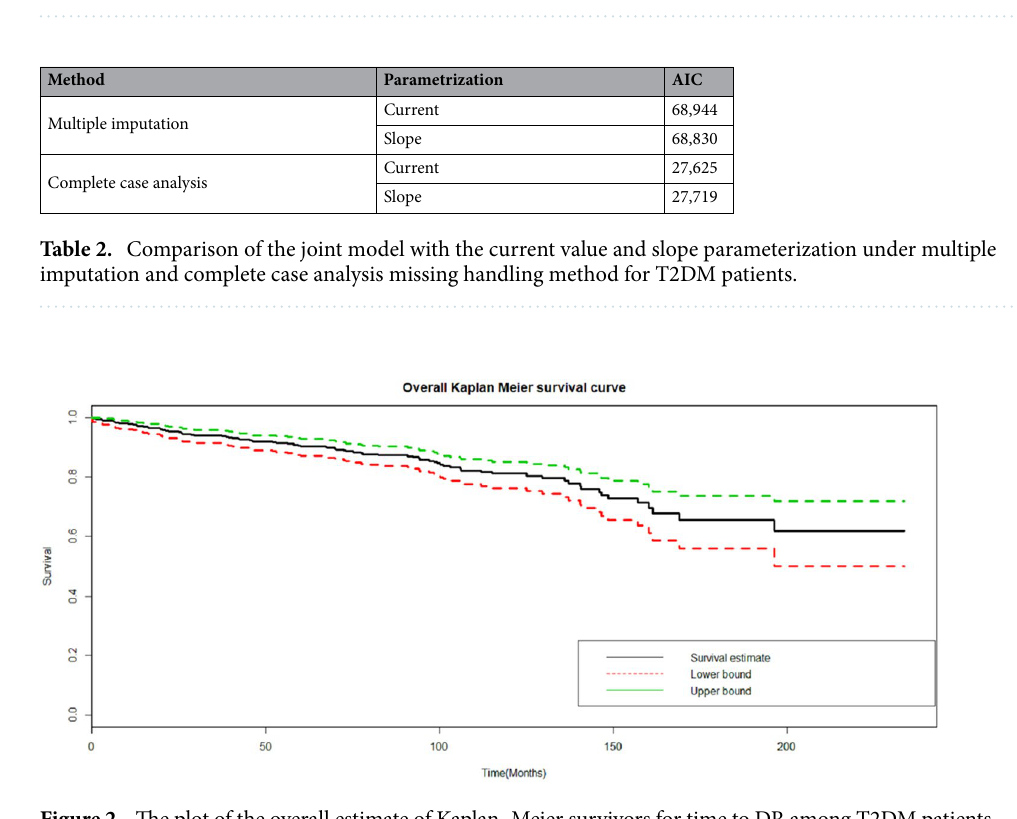
Figure 1. The individual profile plots suggested that there were within- and between-variation changes in FBS measurements over time. The individual trajectory of FBS for patients shows that patients had considerably different FBS at baseline and over time. This suggests that a model with both a random intercept and random slope is required. The red line (loess smoothing technique), which shows the mean structure of FBS measurement over time, suggested a linear change in the mean FBS measurement over time.